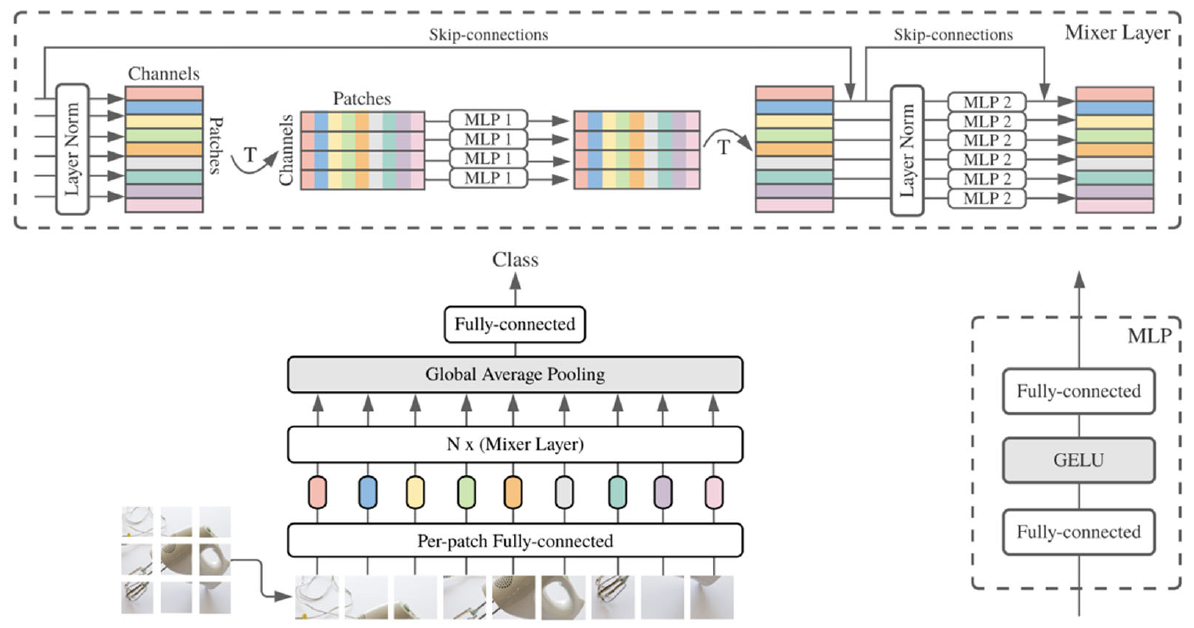
Figure 1. MLP-Mixer architecture used in ref. [9]. Reprinted from ref. [9].